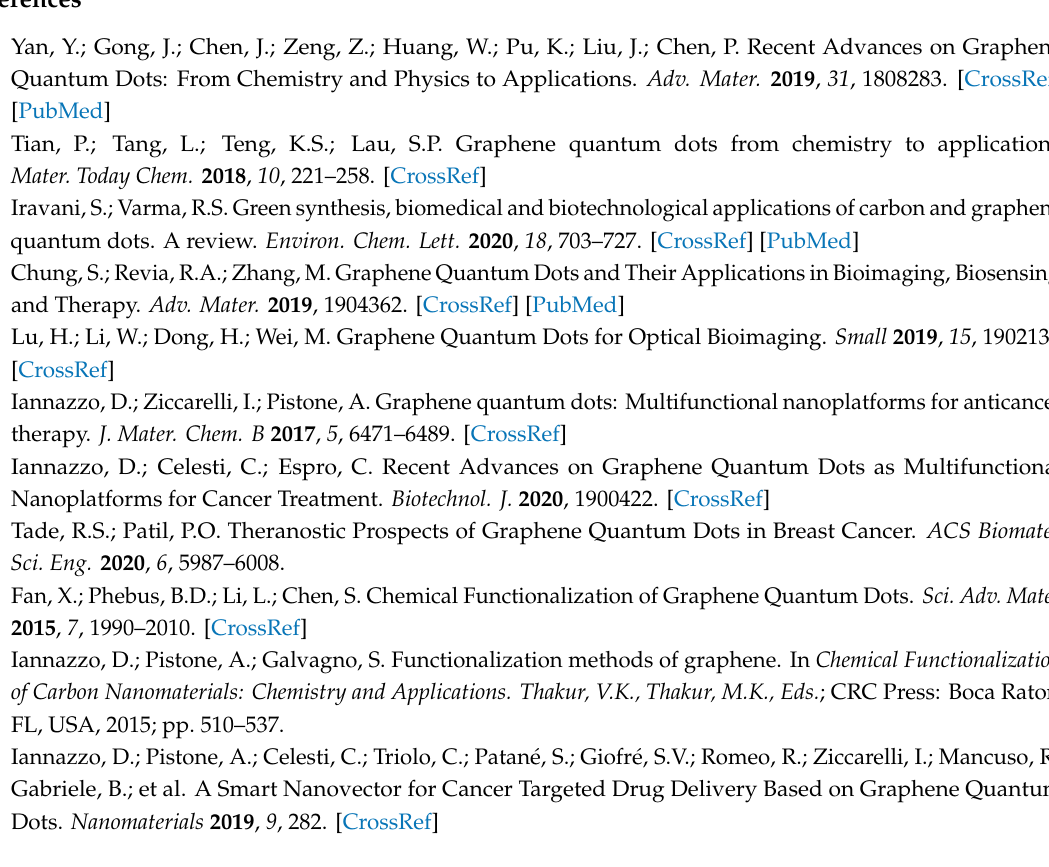
Figure S1: Raman spectra ( λ exc = 532 nm) of pristine MWCNTs and of the synthesized GQDs, Scheme S1: Synthesis of nitrone 2b , Figure S2: Al-K α excited XPS of the GQDs sample in the C 1sbinding energy region, Figure S3: Al-K α excited XPS of the GQDs sample in the O 1s binding energy region, Figure S4: Size distribution and zeta potential values of isox -GQDs 2a and (c) isox -GQDs 2b